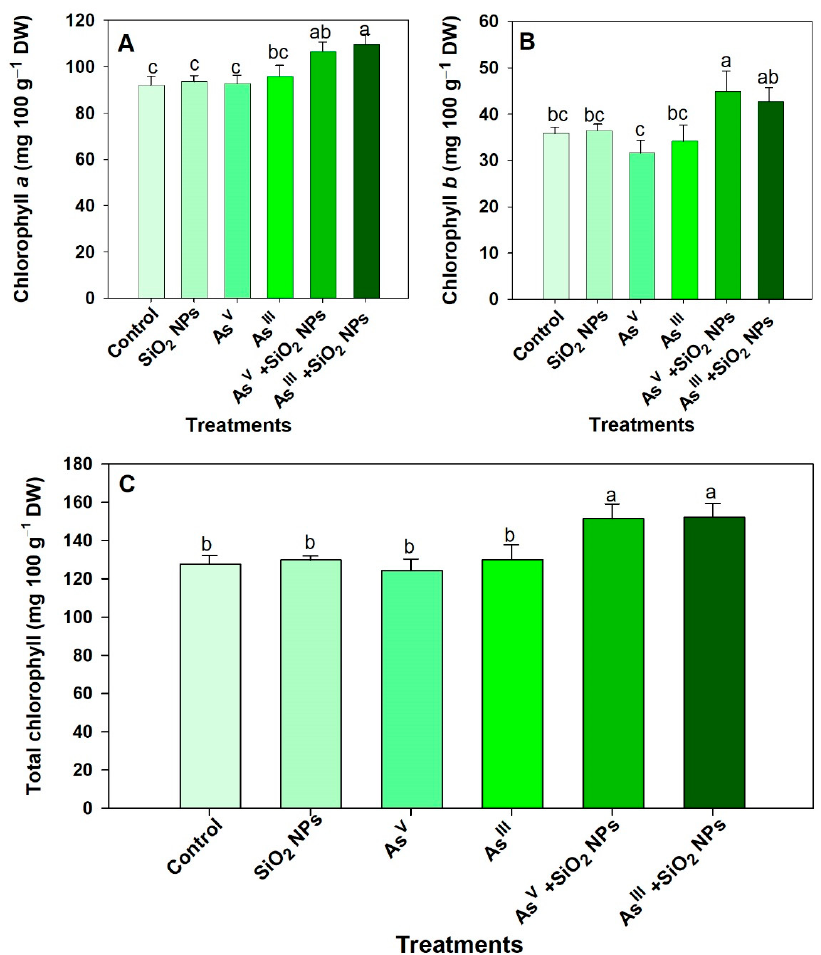
Figure 4. Chlorophylls content in leaves of tomato plants. ( A ) chlorophyll a , ( B ) chlorophyll b , and